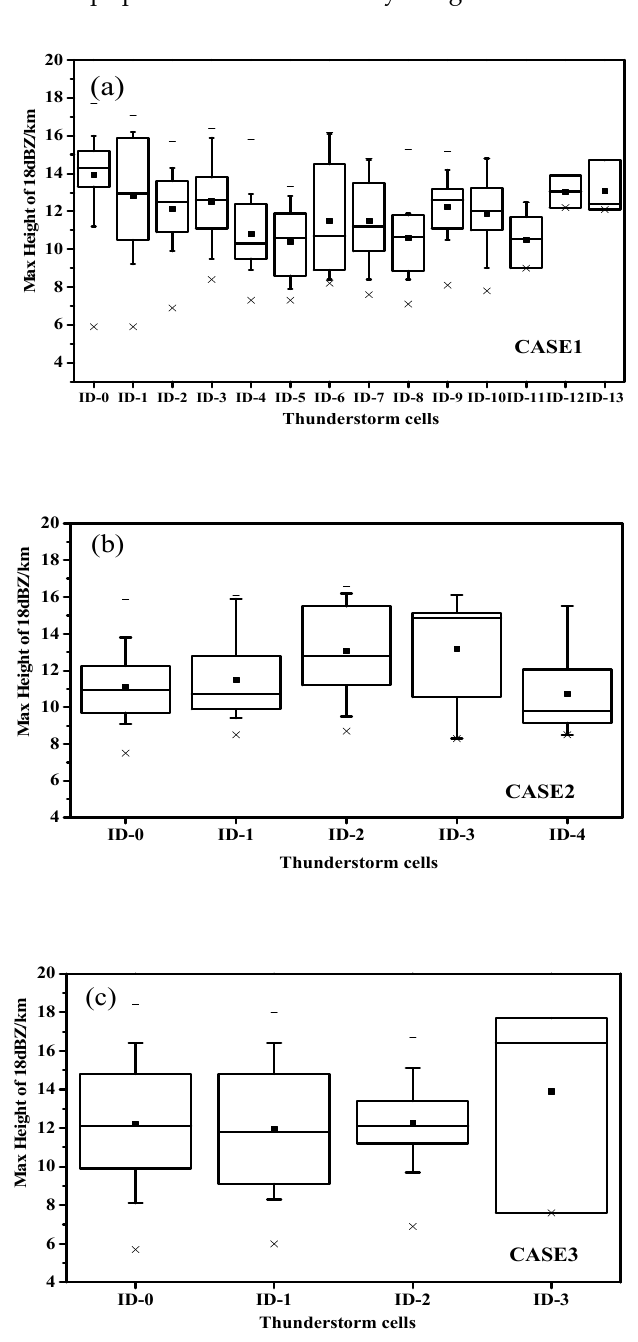
Figure 7. Box-and-whisker plots of the maximum height of 18 dBZ radar echo ( a ) Case 1, ( b ) Case 2, and ( c ) Case 3 in the thunderstorm cells. Box, whiskers, and the black squares show the individual interquartile ranges, 90th and 10th percentile, and the mean value, respectively. The symbol of “ − “ and “ × ” respresent the maximum and minimum.